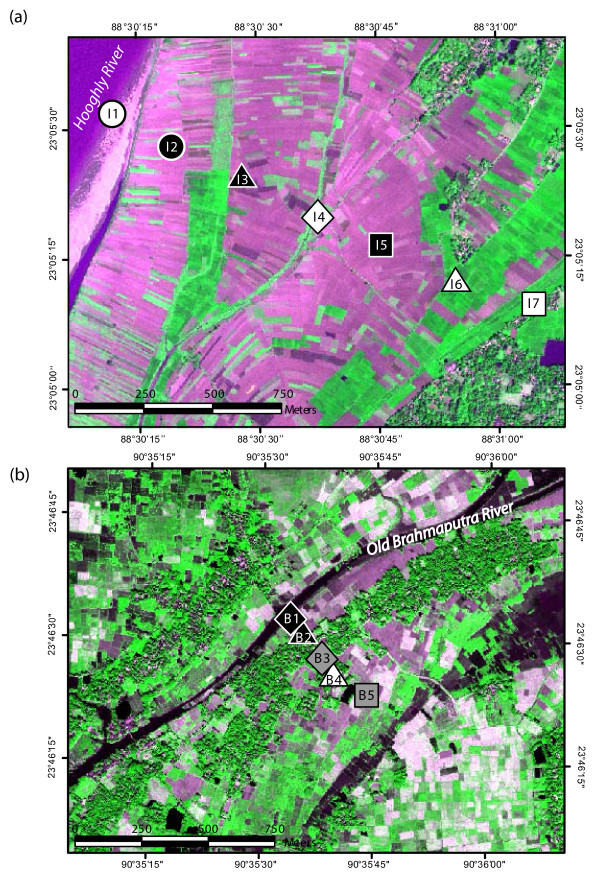
IKONOS satellite images of study areas in (a) India and (b) Bangladesh acquired in April 2000 and November 2000, respectively. The images were processed to emphasize in purple the water contained in streams, ponds, and irrigated rice paddies. Mottled areas indicate trees, which typically correspond to where dwellings are located. Also shown are symbols indicating the positions of needle-sampler profiles obtained in the two study areas. Unlike subsequent figures, the scale is the same for both images.